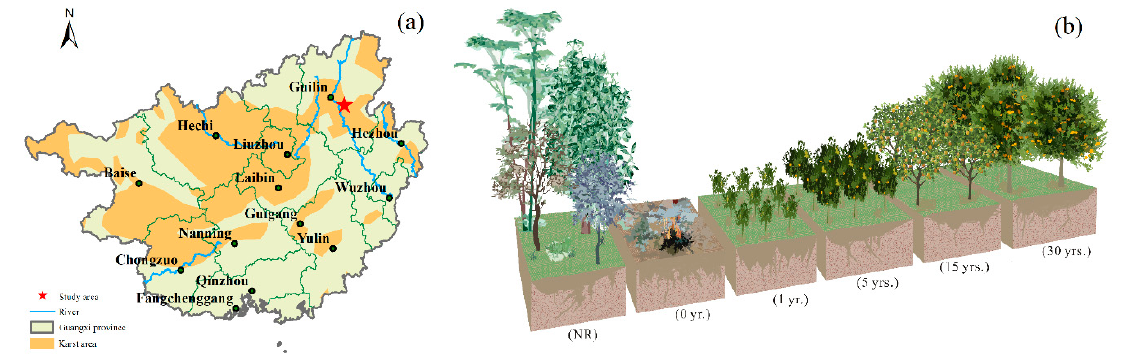
Figure 1. Location of sampling sites in Guilin, Guangxi Zhuang Autonomous Region, China, where ( a ) is the map of Guangxi Province, the red star in figure ( a ) represents the study area, and ( b ) represents different land use types in sampling sites.